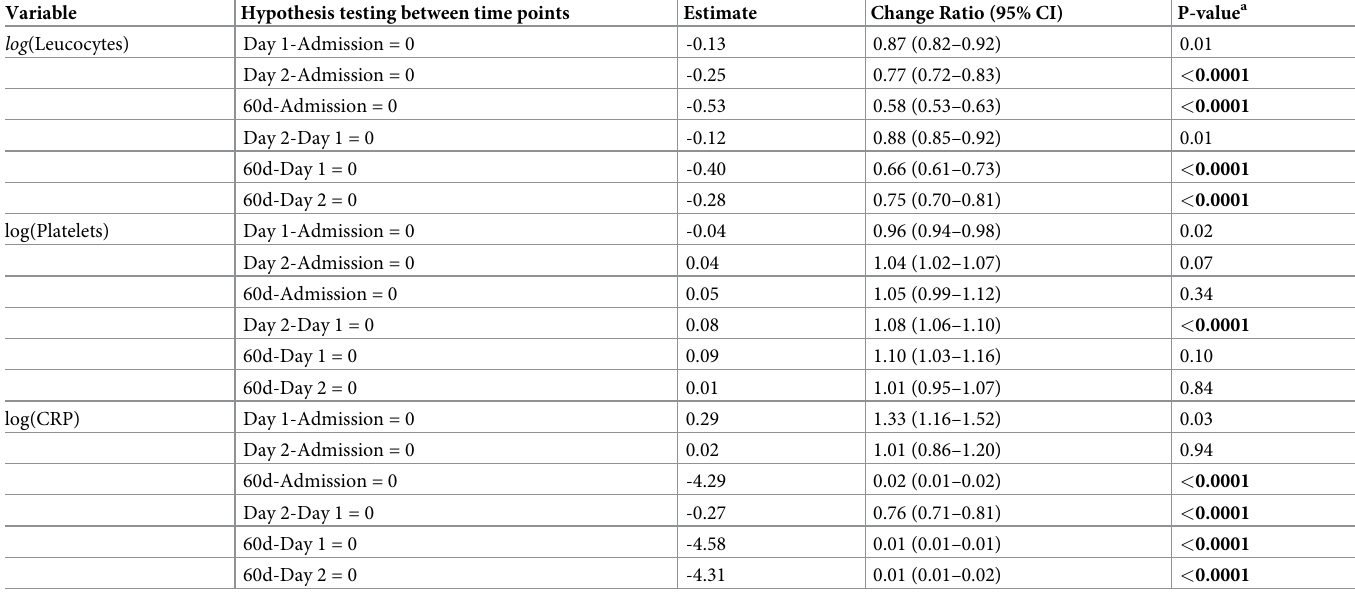
Table 8. Model estimates of relative log (concentrations) and the corresponding ratios of change between the sampling time points for routine blood cell counts ( × 10 9 /L) and CRP (mg/L).